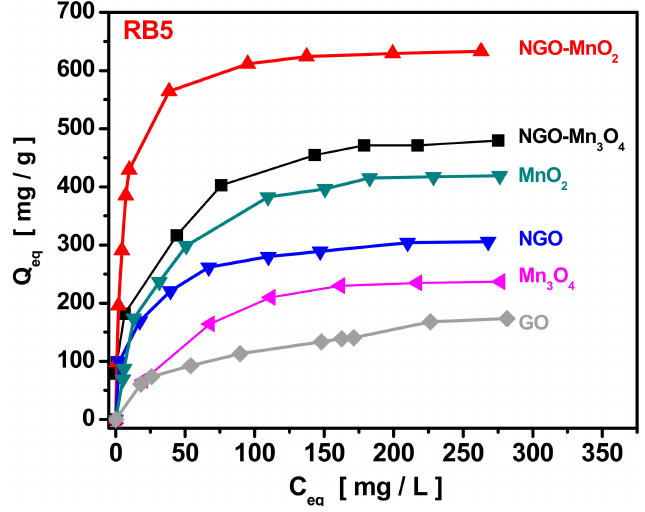
Figure 4. E ff ect of initial concentration of RB5 (pH = 3, m = 0.01 g, V = 0.02